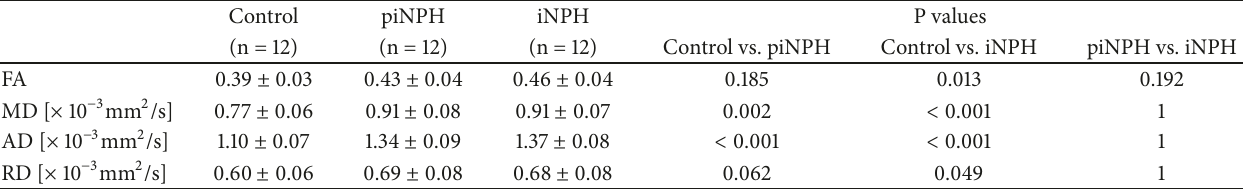
Table 3: DTI changes in periventricular projection fiber